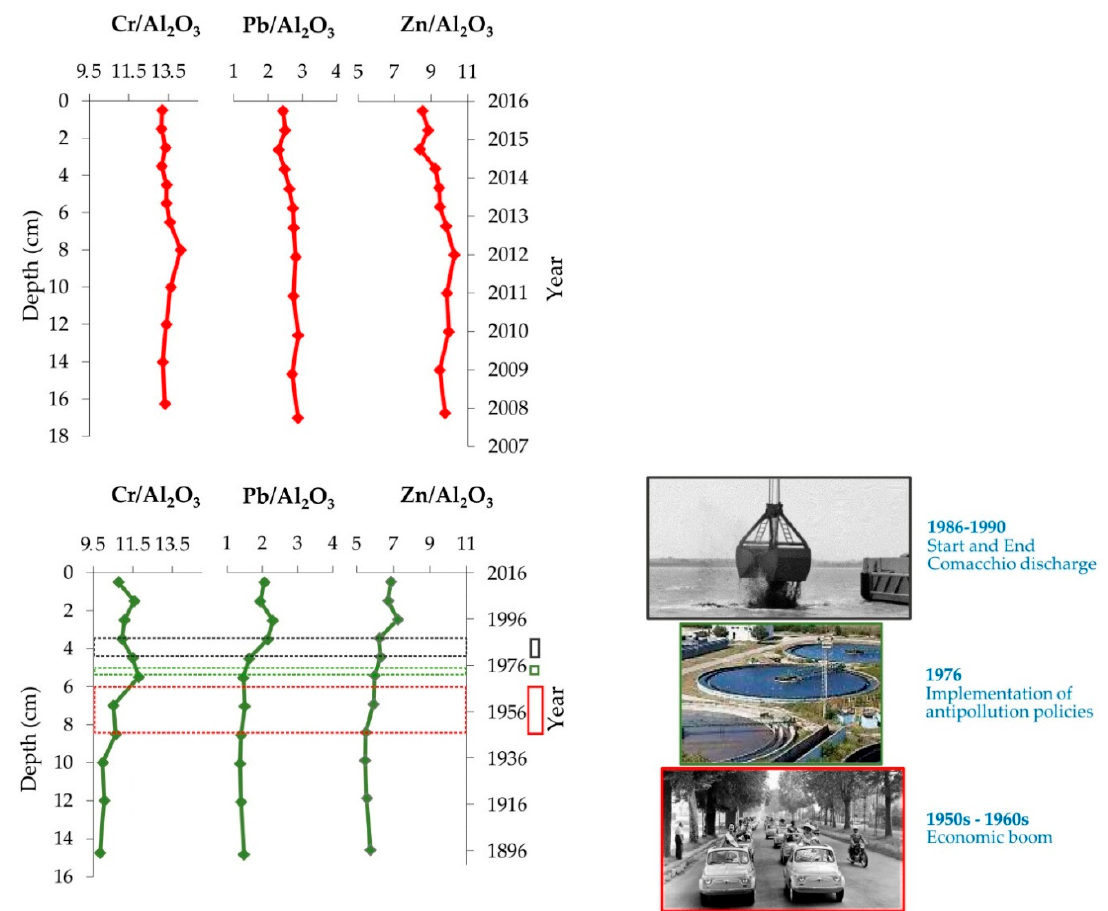
Figure 7. Down-core variability of geochemical proxies (Pb / Al 2 O 3 and Zn / Al 2 O 3 ) in S1 (red line) and Figure 7. Down ‐ core variability of geochemical proxies (Pb/Al 2 O 3 and Zn/Al 2 O 3 ) in S1 (red line) and E1 (green line) measured in ANOC16 E1 (green line) measured in ANOC16 cores.